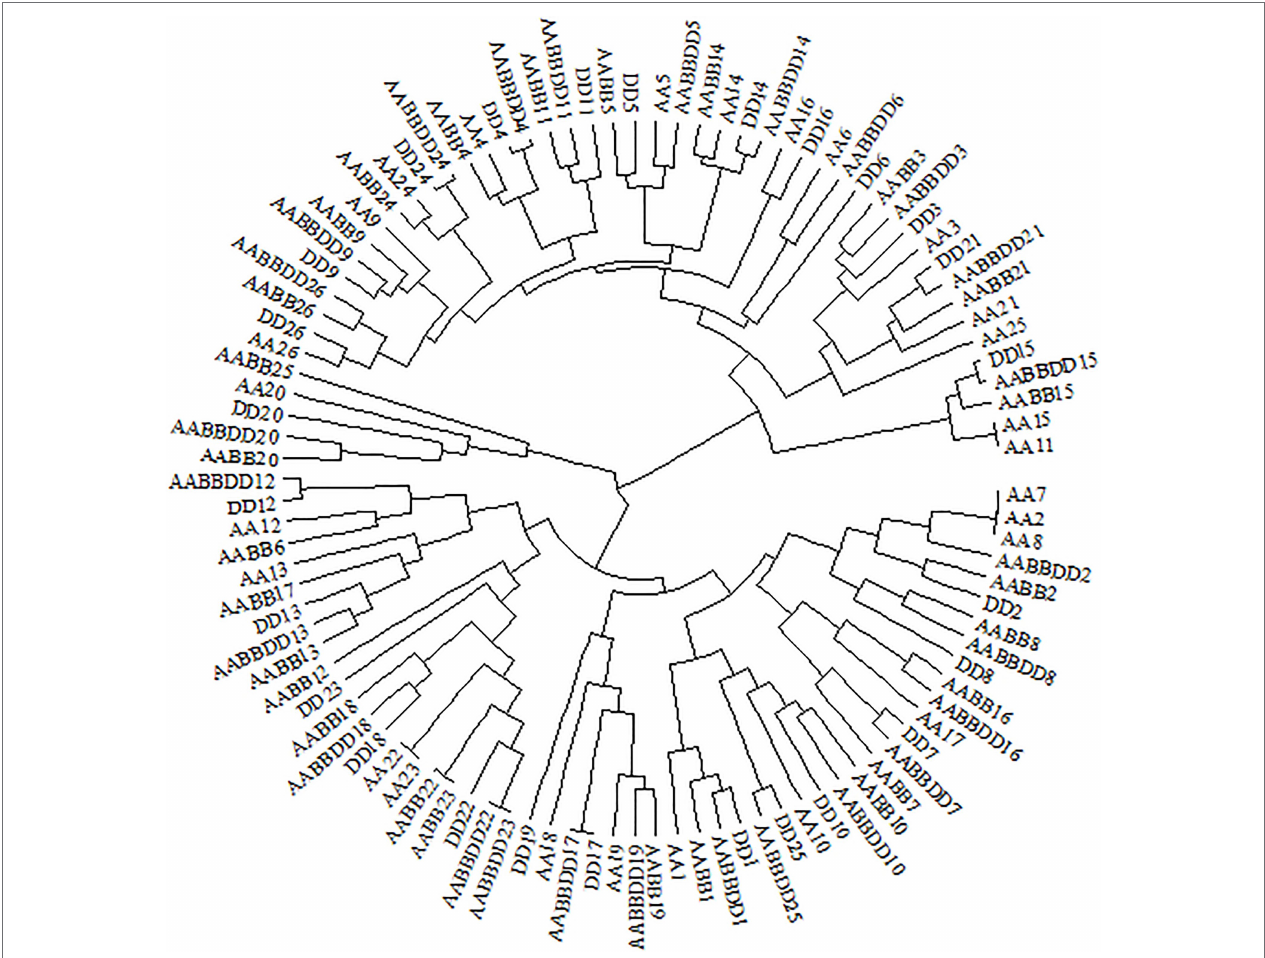
FIGURE 8 | Clustering tree of CCT genes from Triticum aestivum (AABBDD), Aegilops tauschii (DD), Triticum turgidum (AABB), and Triticum urartu (AA) according to RSUC values for 59 synonymous